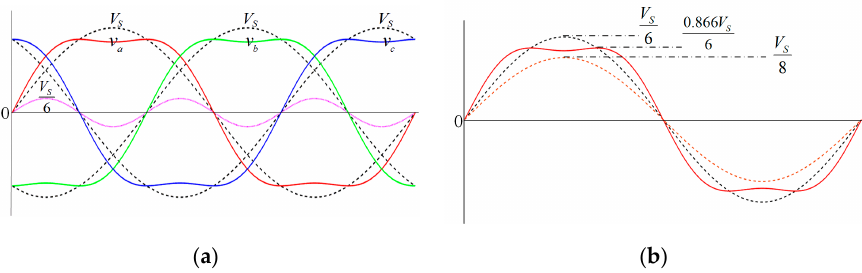
Figure 4. Third harmonic injection control block diagram. ( a ) Three-phase modulating waveforms in pre-fault and post-fault conditions. ( b ) Submodule output voltages in Phase A in pre-fault and post-fault conditions.